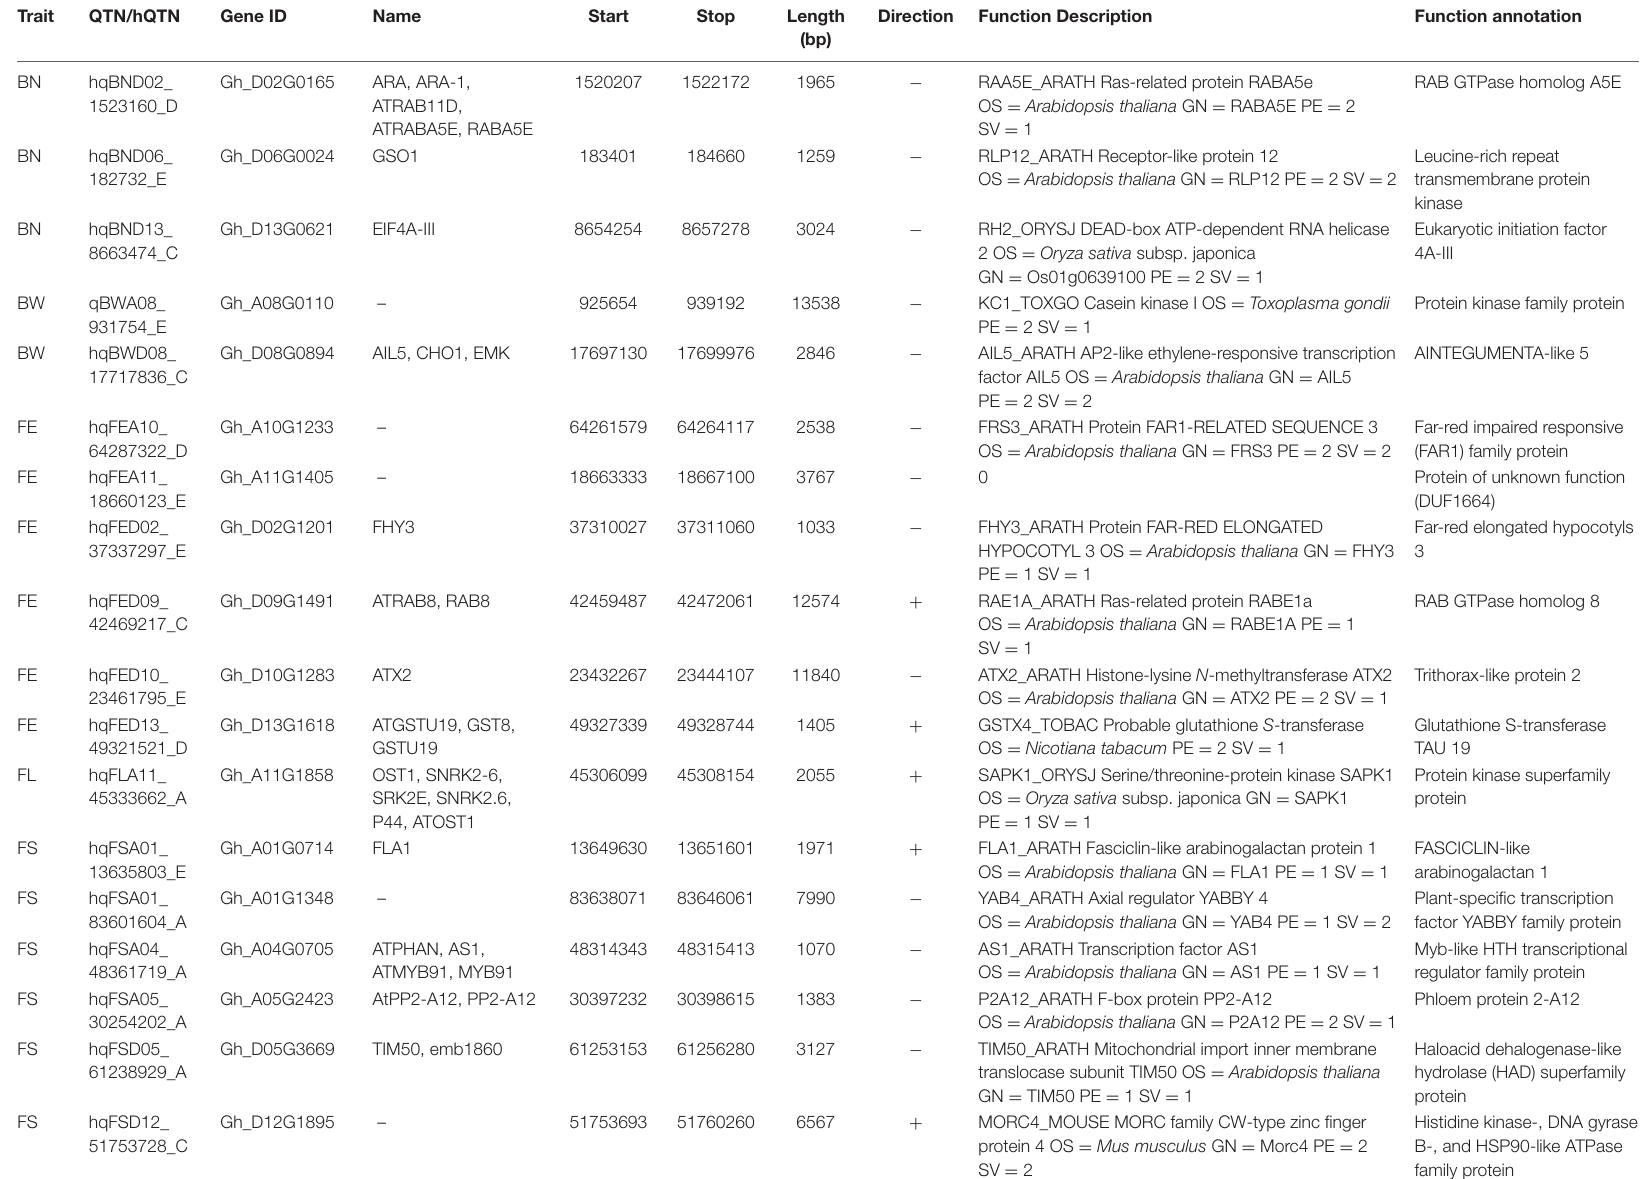
TABLE 1 | List of 64 candidate genes related to fiber quality and yield related traits with their details about biological function (GO items) annotations.